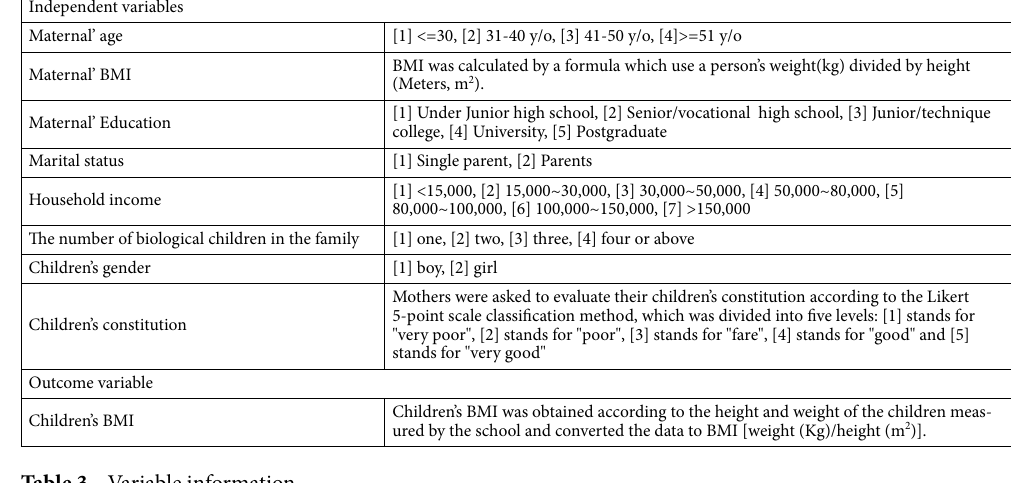
Table 3. Variable